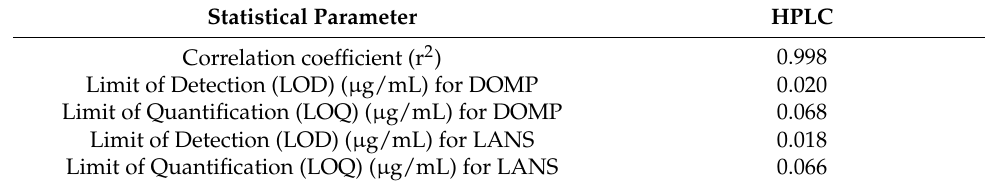
Table 2. Linear regression data for DOMP and LANS.